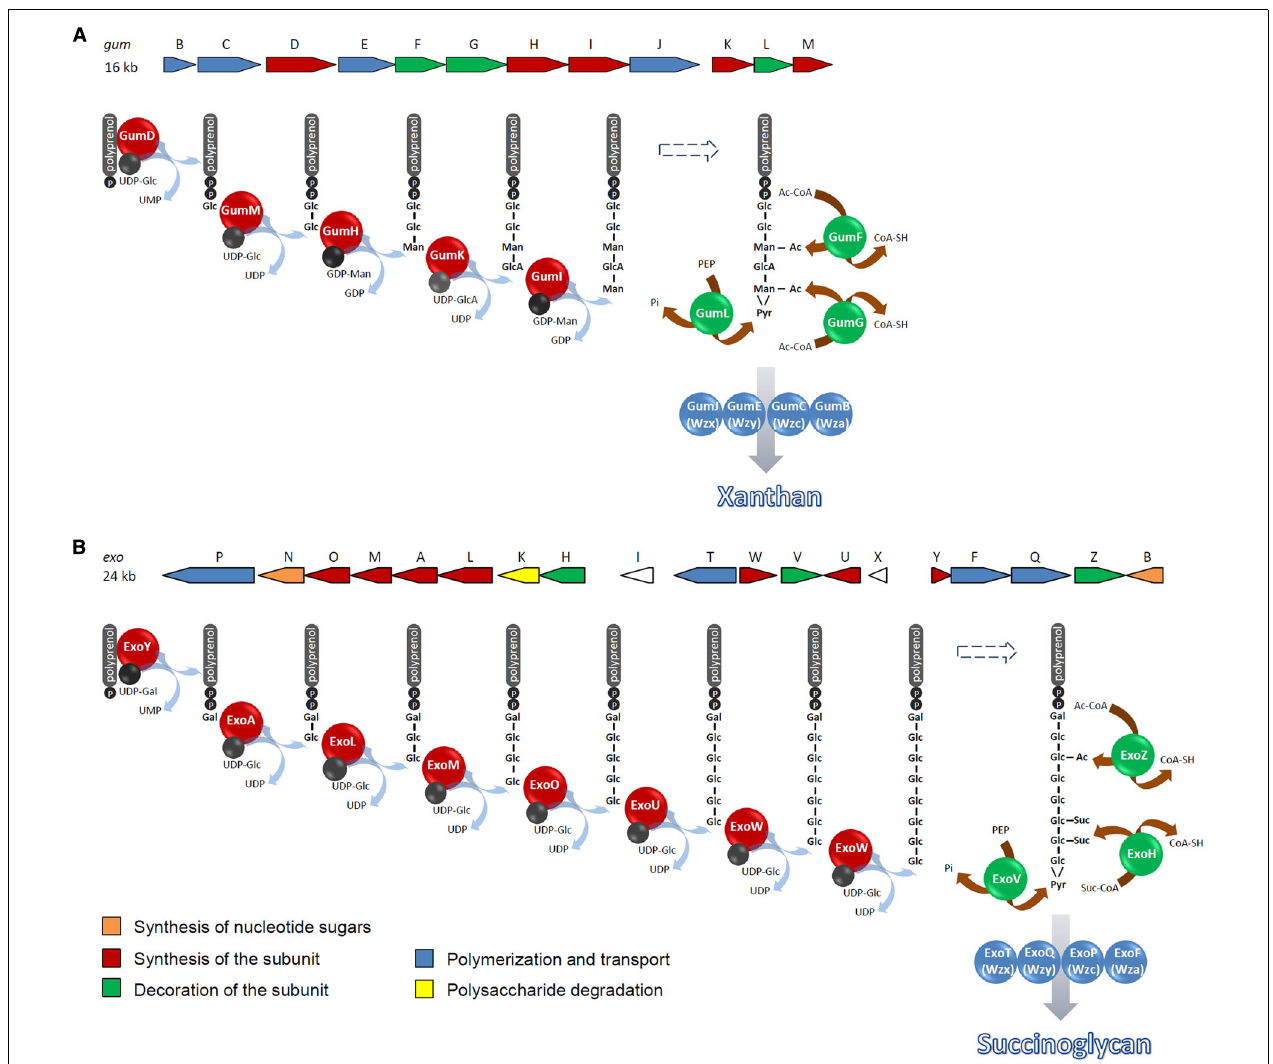
FIGURE 2 | Biosynthetic pathways of xanthan in X. campestris (A) and succinoglycan in S. meliloti (B). Repeat units are synthesized on a C55-undecaprenol phosphate lipid carrier at the inner face of the cytoplasmic membrane. Polymerization occurs by transfer of the lipid carrier-bound growing chain to a monomeric lipid carrier-bound repeat unit in the periplasm at the outer face of the cytoplasmic membrane. Modifications may occur